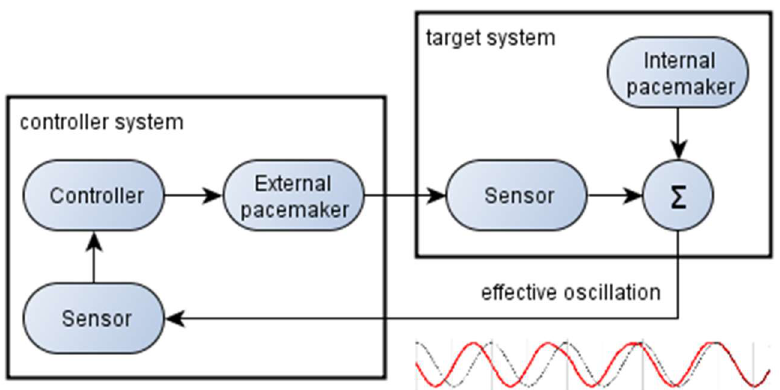
Figure 6. The concept of active entrainment is at the core of the Virtual Human Breathing Relaxation System (VHBRS). The breathing of a Virtual Human serves as the external pacemaker that influences the breathing rhythm of the target system, i.e., the user.